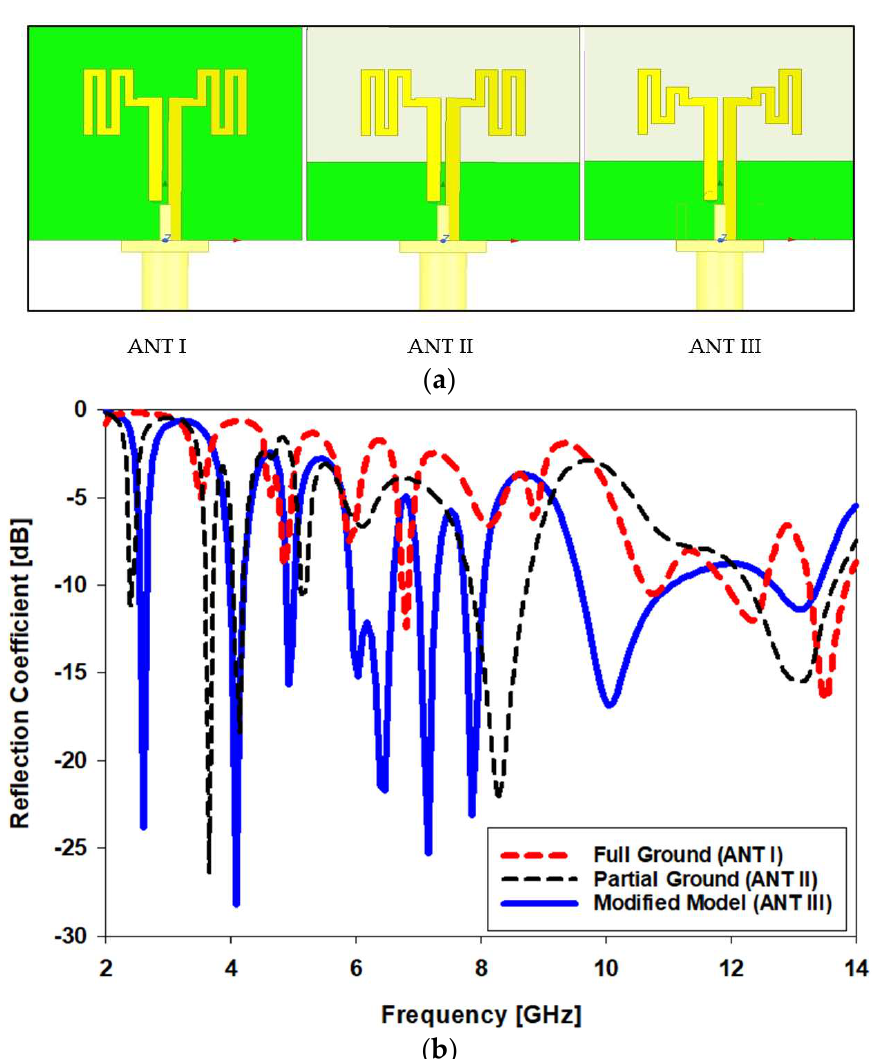
Figure 2. ( a ) Proposed antenna design steps; ( b ) reflection coefficient comparison for the design steps.